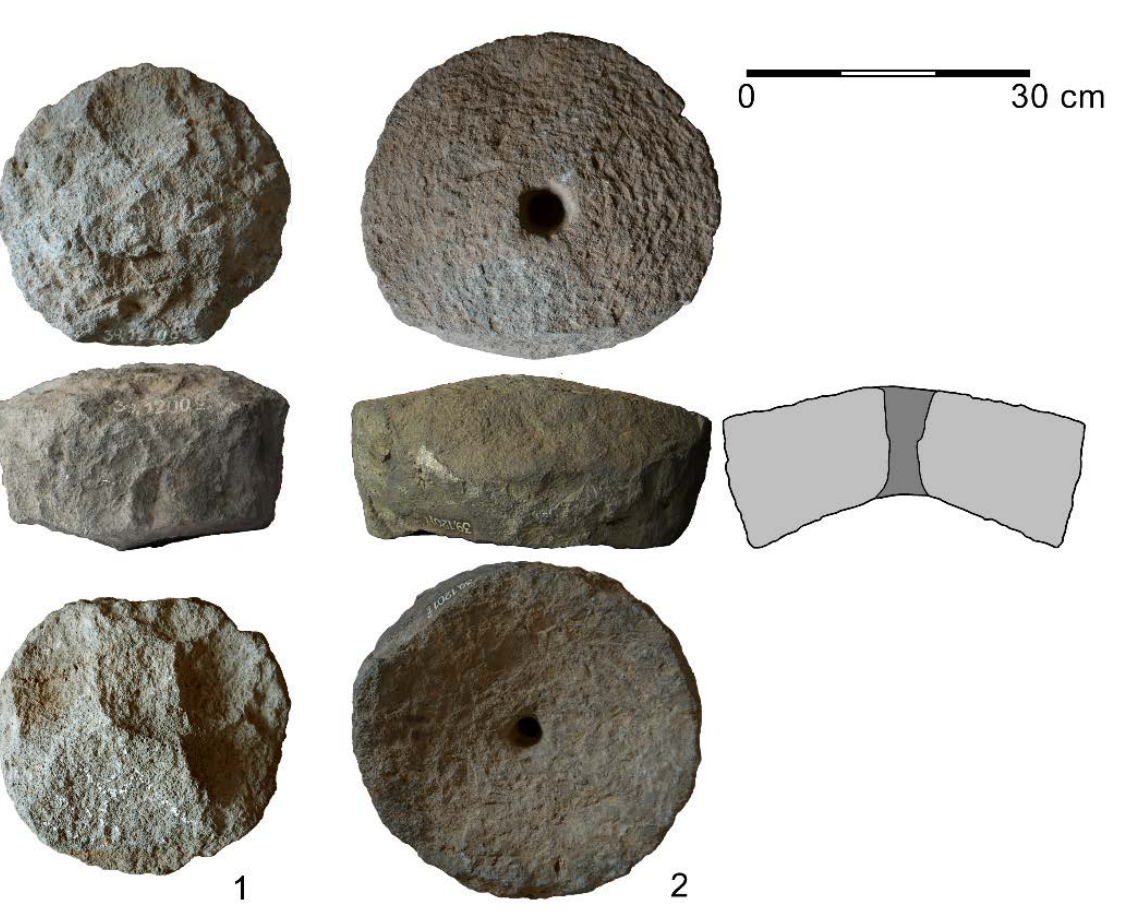
Figure 4. Roughouts for lower stones, probably of Brillerij type, from Kottenheim, “Im Hengst“ (1 pit 3; 2 pit 5). “Basalt”-like